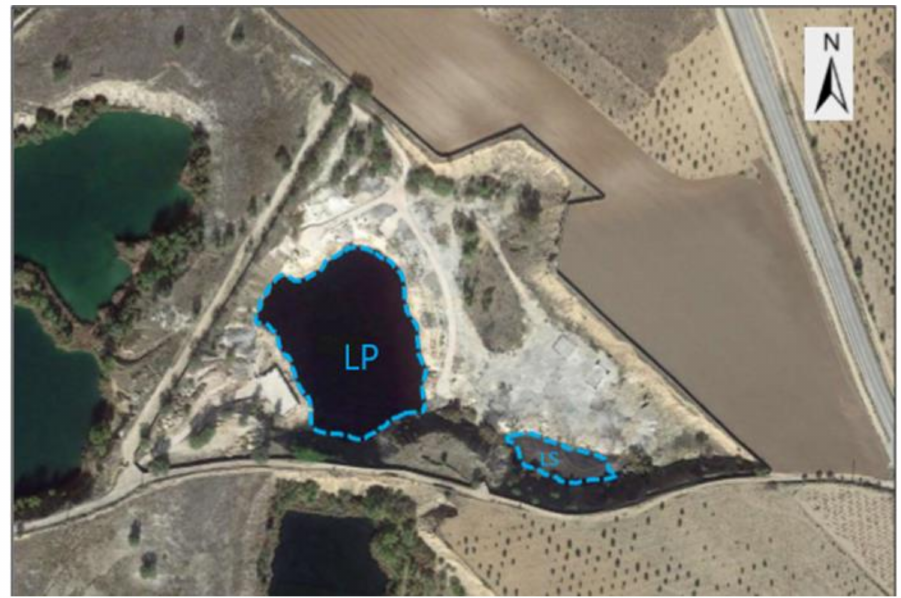
Figure 1. Aerial photo of the area under